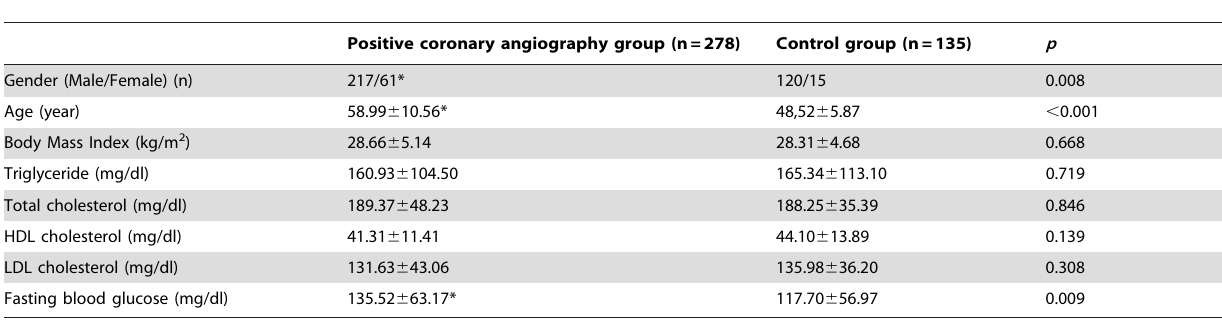
Table 2. General characteristics of the study population.